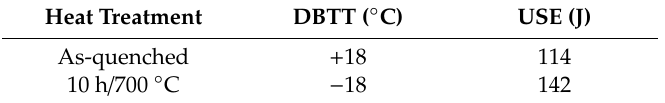
Table 2. Ductile to brittle transition temperature (DBTT) and USE values determined from the curves in Figure 2.